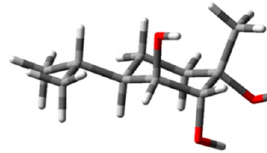
Figure 3. The most stable conformer (DFT/B3LYP/6-31G(d)/IEFPCM(CH 3 CN)) of (1 S ,2 R ,3 S ,4 R )- 1 . The structure atoms are coloured as follow: carbon (grey), hydrogen (light grey), oxygen (red).